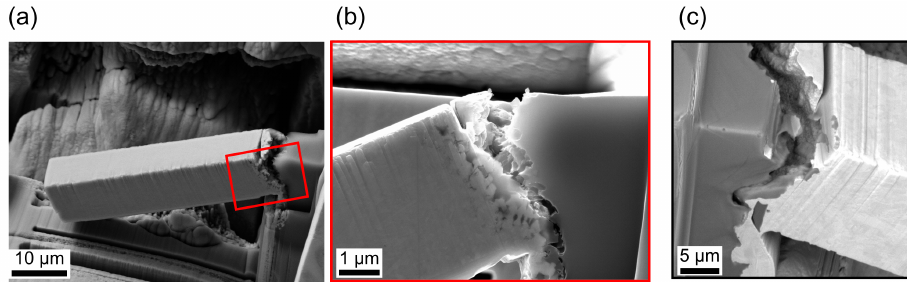
Figure 10. Post mortem SEM images from ( a ) pre-treated microcantilever with ( b ) a detailed view and ( c ) untreated microcantilever. The different crack path is